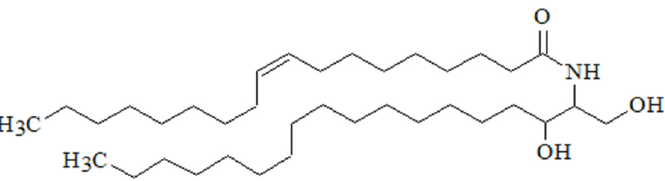
Figure 1. Scheme of the molecular structure of (9Z)-N-(1,3-dihydroxyoctadecan-2-yl)octadec-9- enamide (a ceramide-like molecule).